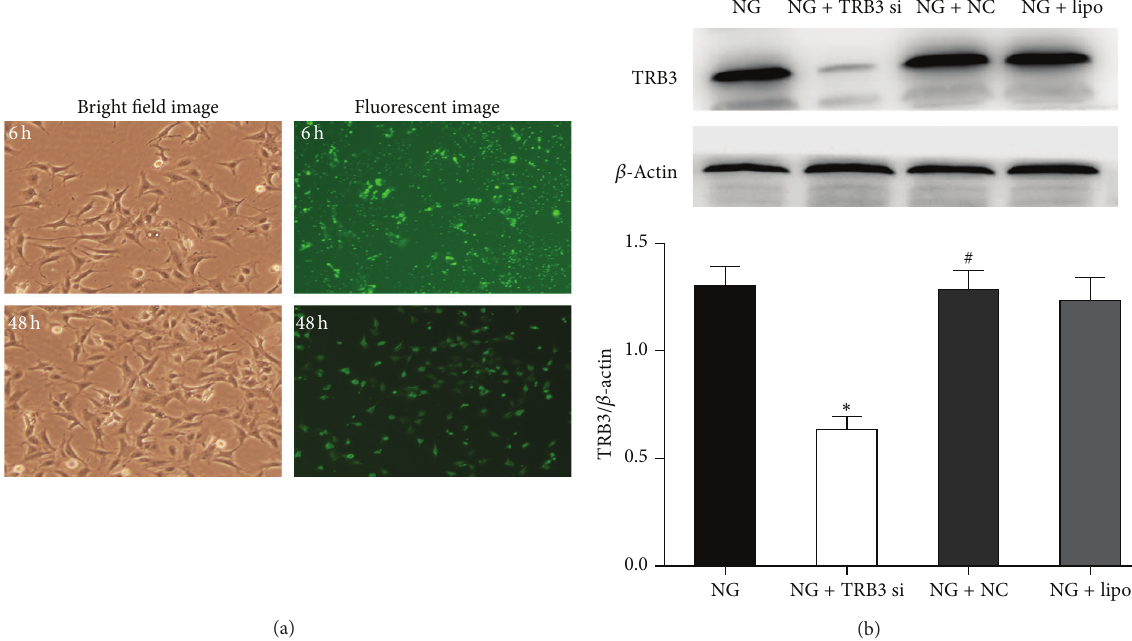
Figure 6: Effect of siRNA on the expression of FAM and TRB3 in cells. Transient transfection of cells with TRB3 siRNA induced FAM expression, indicating successful transfection. FAM expression was observed at 0 and 48 h after transfection. Cells were transfected with TRB3 siRNA or its corresponding negative control and then incubated with NG (5.5 mM glucose) for 48 h. (a) FAM expression was observed by bright field and fluorescent imaging (200x). (b) Western blot analysis of the protein expression of TRB3 at 48 h after TRB3 siRNA transfection. Data are mean ± SEM. ∗ 𝑃 < 0.05 versus NG; # 𝑃 < 0.05 versus NG +TRB3